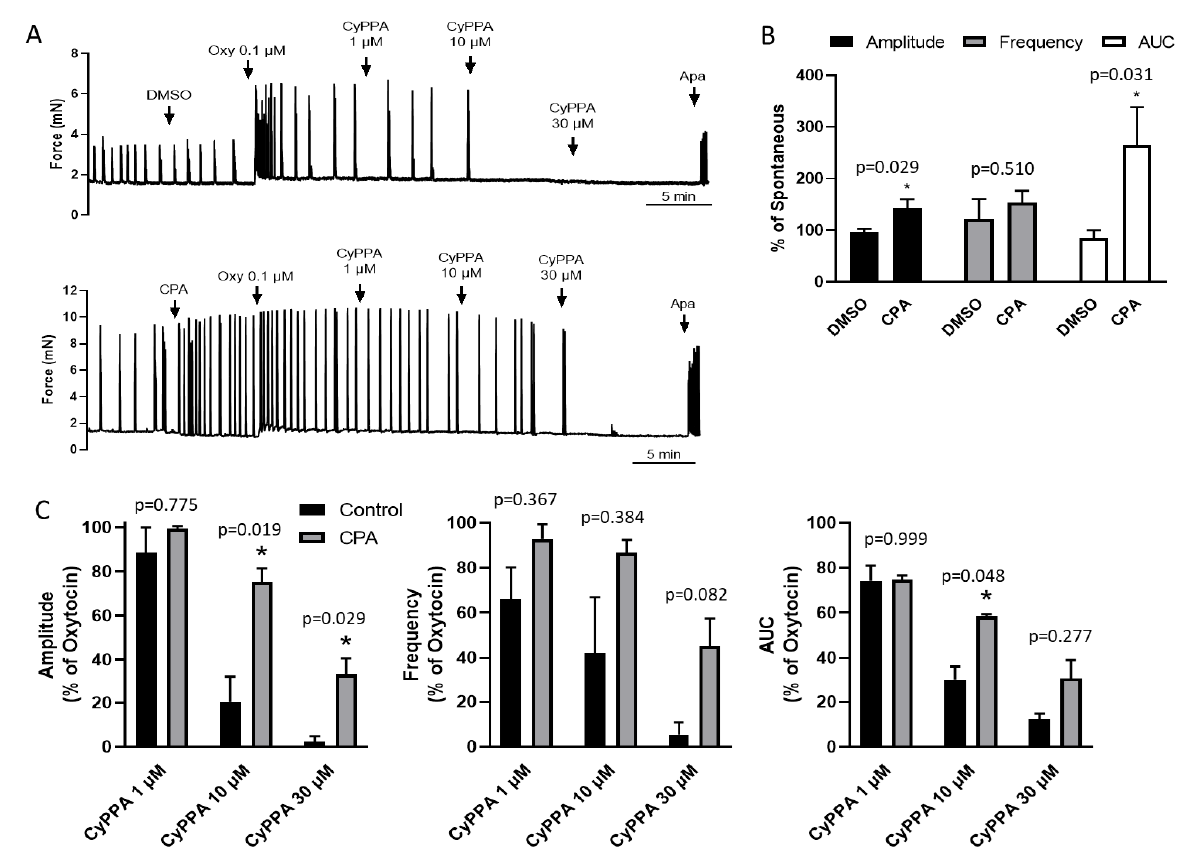
Figure 2. Effect of internal Ca 2+ store depletion on CyPPA suppression of phasic uterine contractions. ( A ) Representative myography recording of uterine strips pretreated with CPA (10 µ M) or DMSO vehicle (0.05%) before exposure to oxytocin and subsequent increasing concentrations of CyPPA. Finally, strips were exposed to the K Ca 2 inhibitor apamin (0.6 µ M). ( B ) Summary of CPA effects on contraction amplitude, frequency and AUC. ( C ) Summary of CyPPA effects on contraction amplitude, frequency and AUC under the conditions tested. Asterisk (*) indicates p < 0.05; (n = 6).